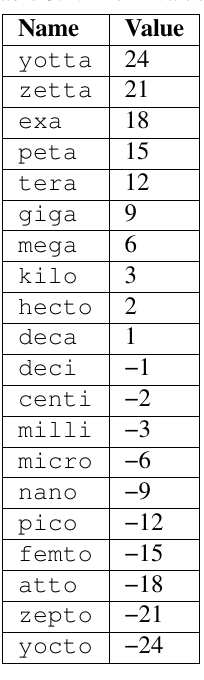
Table 3.2: Prefix